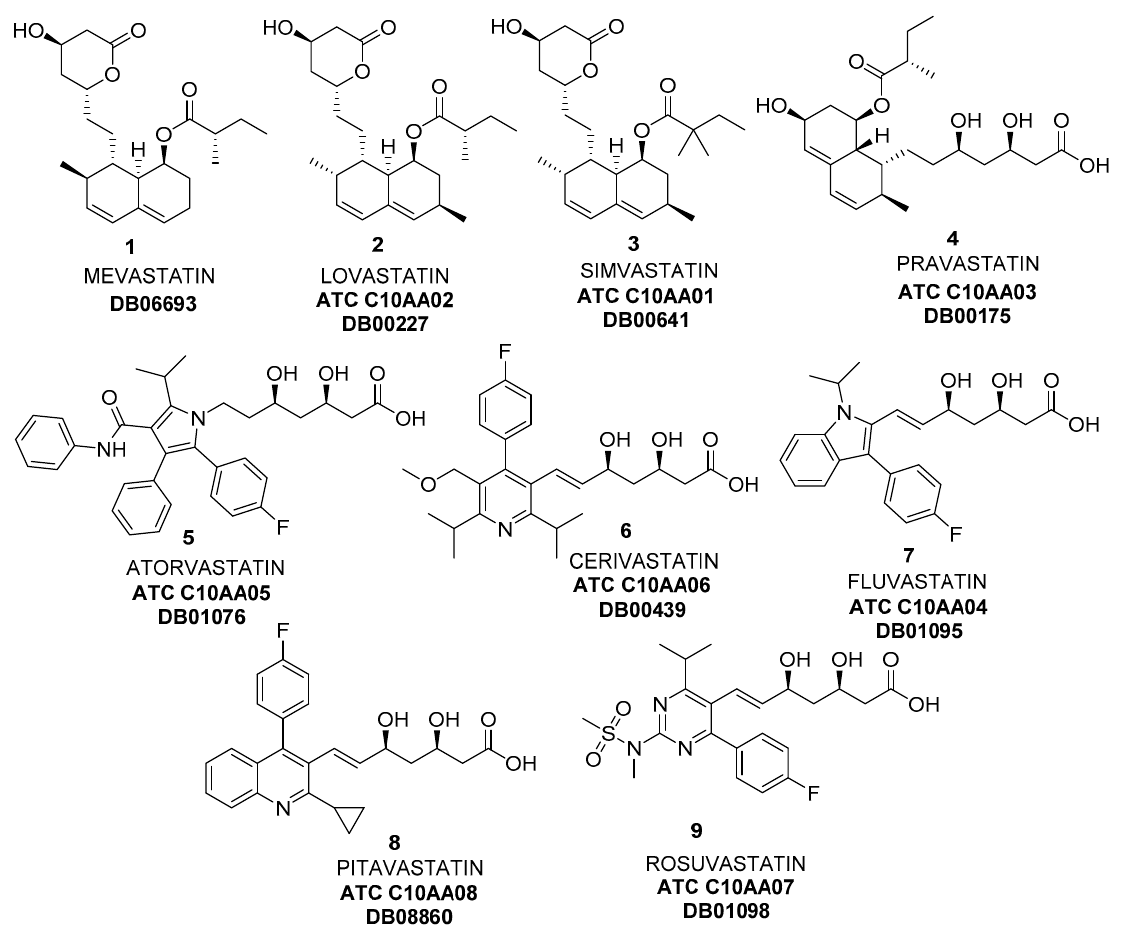
Figure 1. Some Statins, inhibitors of 3-hydroxy-3-methylglutaryl coenzyme A (HMG-CoA) reductase.